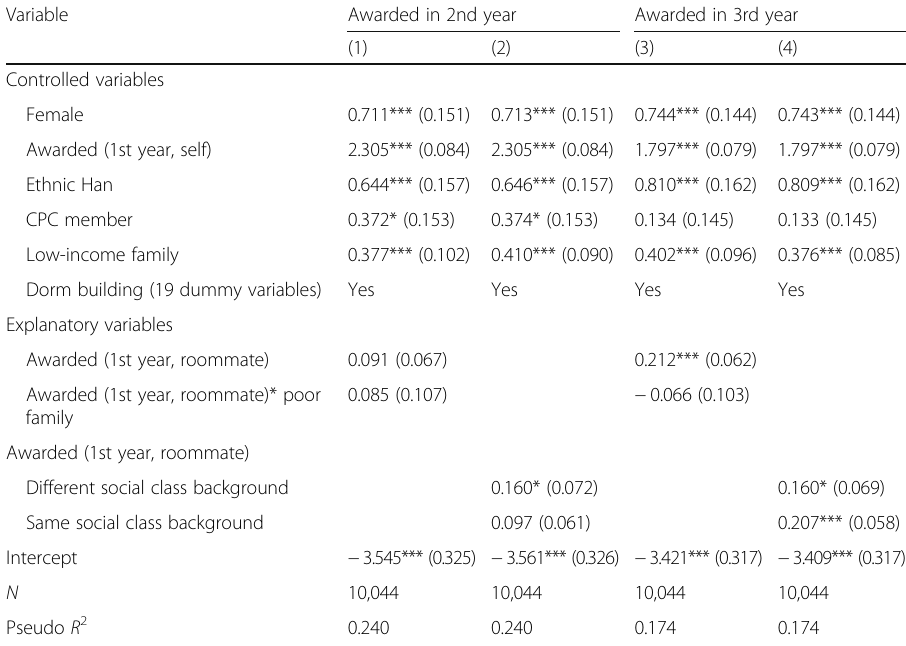
Table 4 Moderation effects of social class on peer social capital